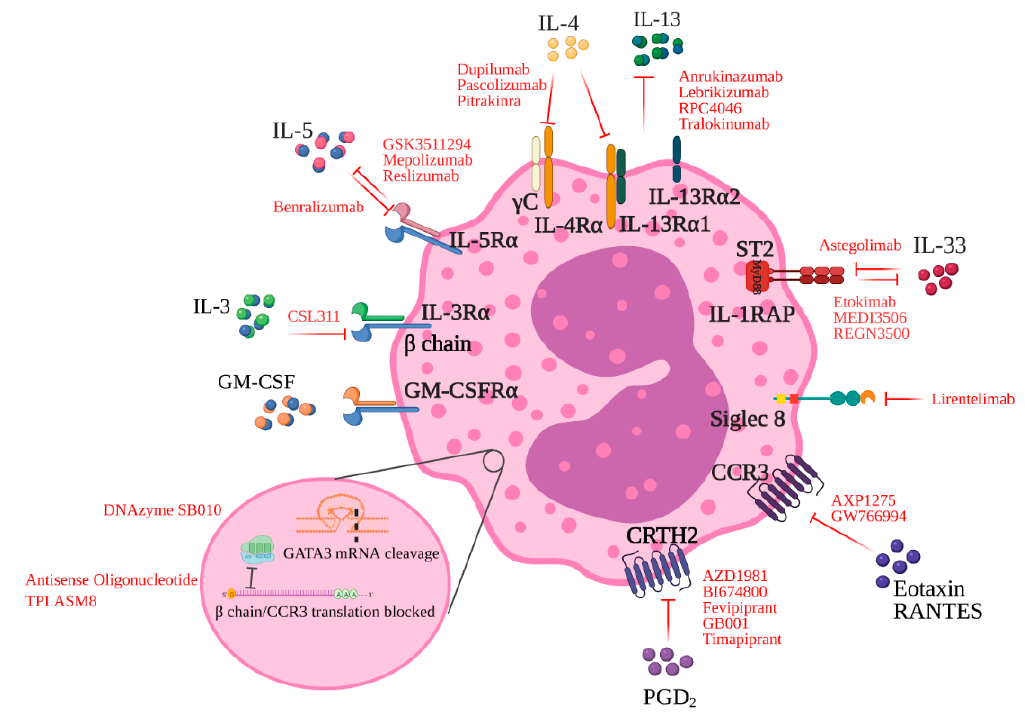
Figure 1. Eosinophil-targeted therapies and their ligands.